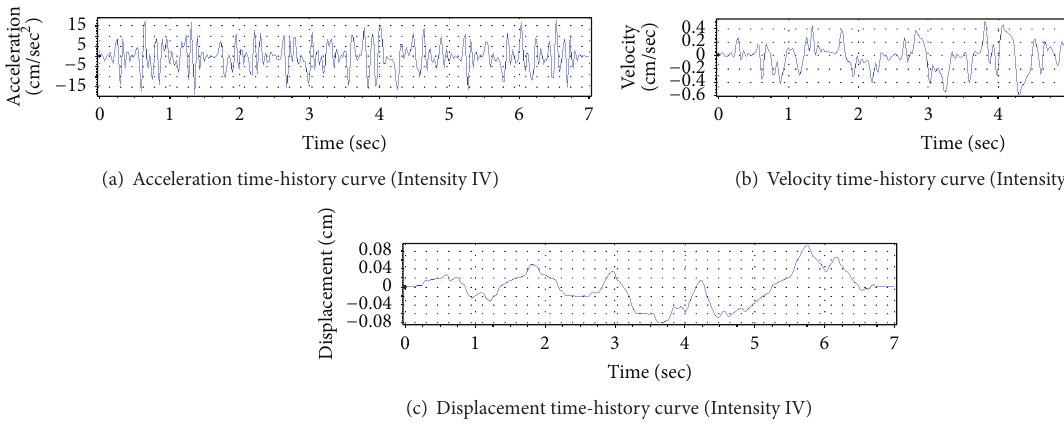
Figure 9: Original seismic wave time-history curve (Intensity